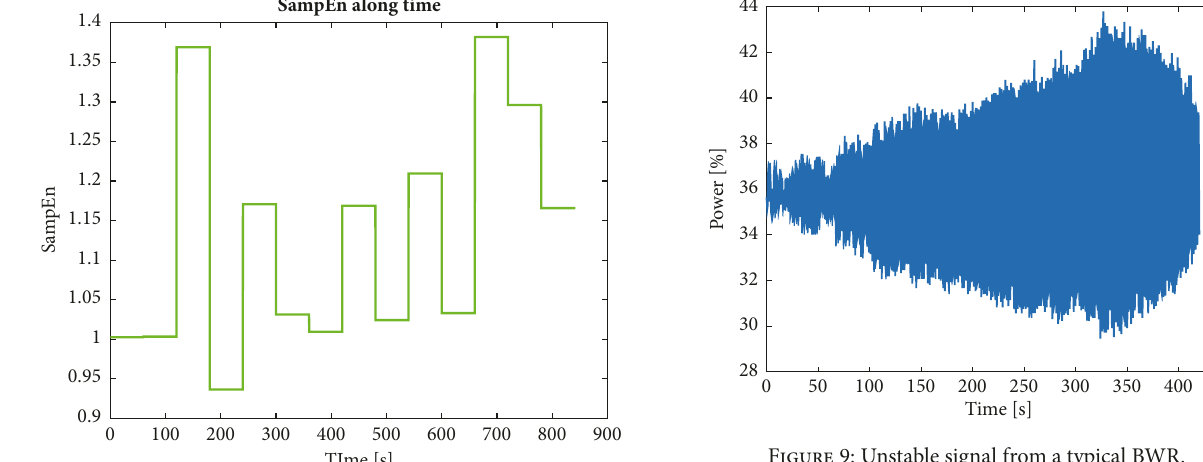
Figure 9: Unstable signal from a typical BWR.